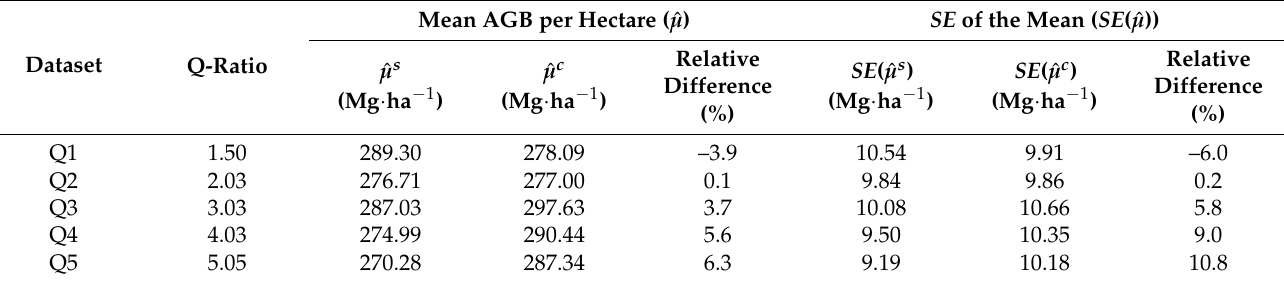
Table 2. The estimates of mean AGB per hectare and of SE , in Mg · ha–1, by model form and dataset. ˆ µ s is the mean AGB per hectare based on the separate variable model, Equation (8); ˆ µ c is the mean AGB per hectare based on the separate variable model, Equation (9); SE ( ˆ µ s ) is the standard error of ˆ µ s , Equation (10); SE ( ˆ µ c ) is the standard error of ˆ µ c , Equation (11). The relative difference was calculated as the ratio between the difference (i.e., the estimates of the combined variable model minus the estimates of the separate variable model) and the estimates based on the separate variable model, multiplied by